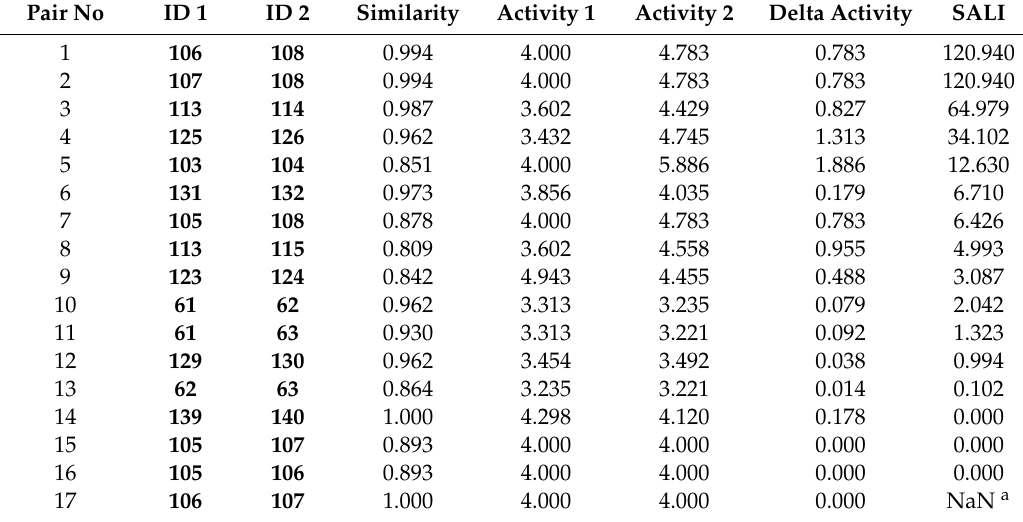
Table 5. Structure-Activity Landscape Index (SALI) analysis of structurally related compounds with antioxidant